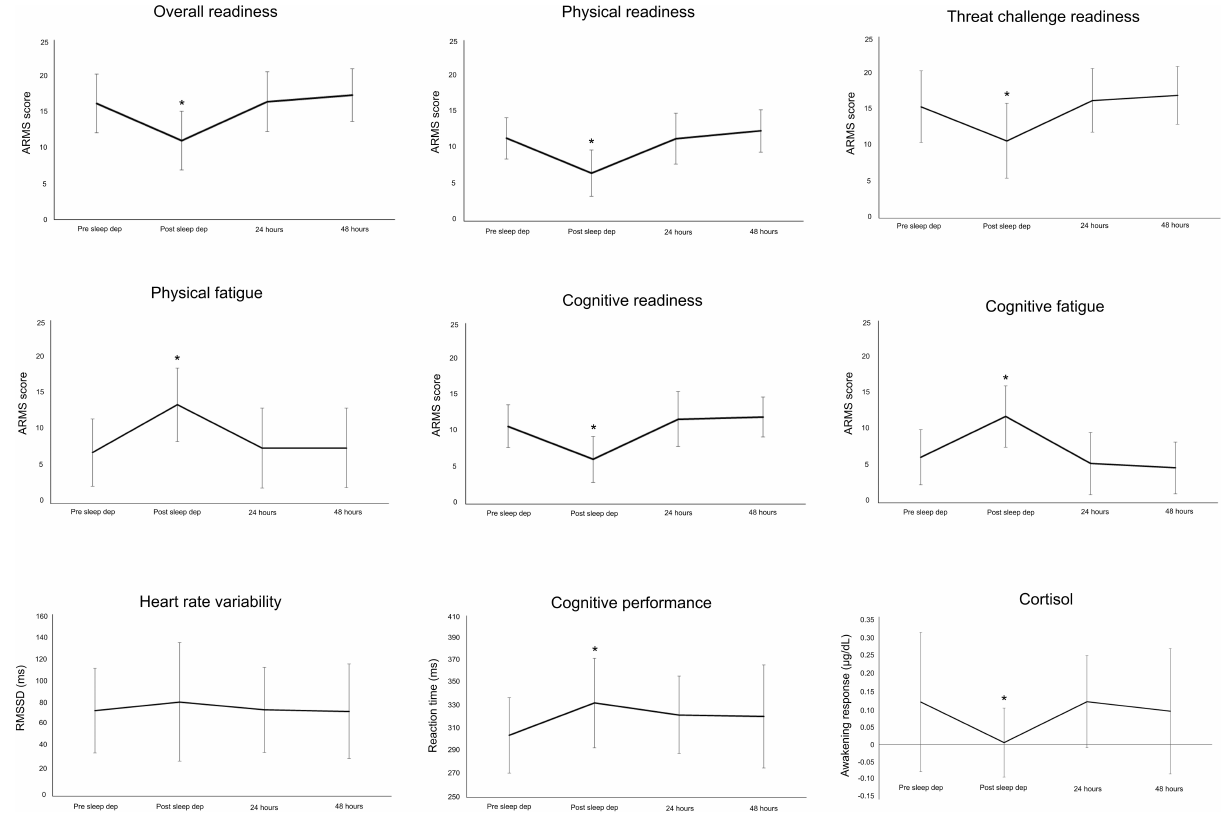
FIGURE 4 | Mean and standard deviation for each subscale of the Acute Readiness Monitoring Scale (ARMS), heart rate variability (root mean square of successive differences between normal heartbeats, RMSSD), cortisol, and cognitive performance before (pre-sleep dep), immediately after (post-sleep dep), and 24 and 48h post the sleep deprivation protocol. * p < 0.05 to pre-sleep dep